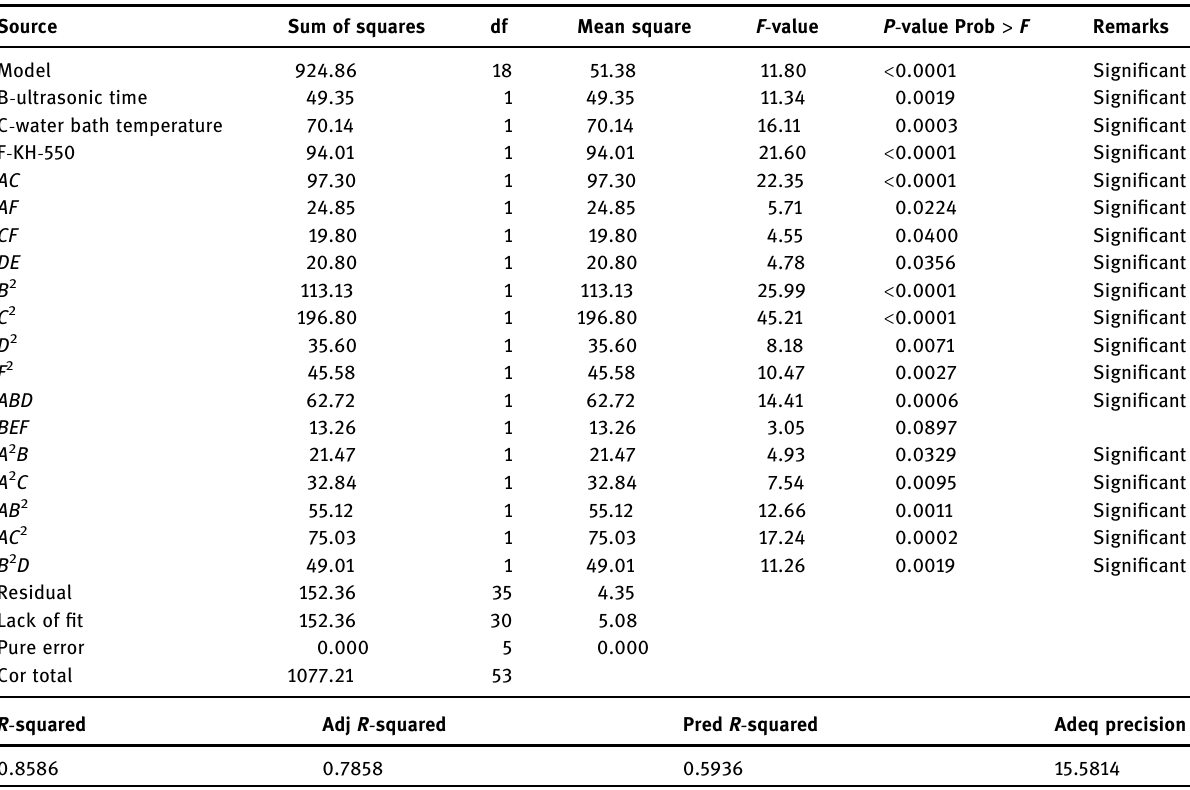
Table 5: Variance analysis of response surface experiments of contact angle Source Sum of squares df Mean square